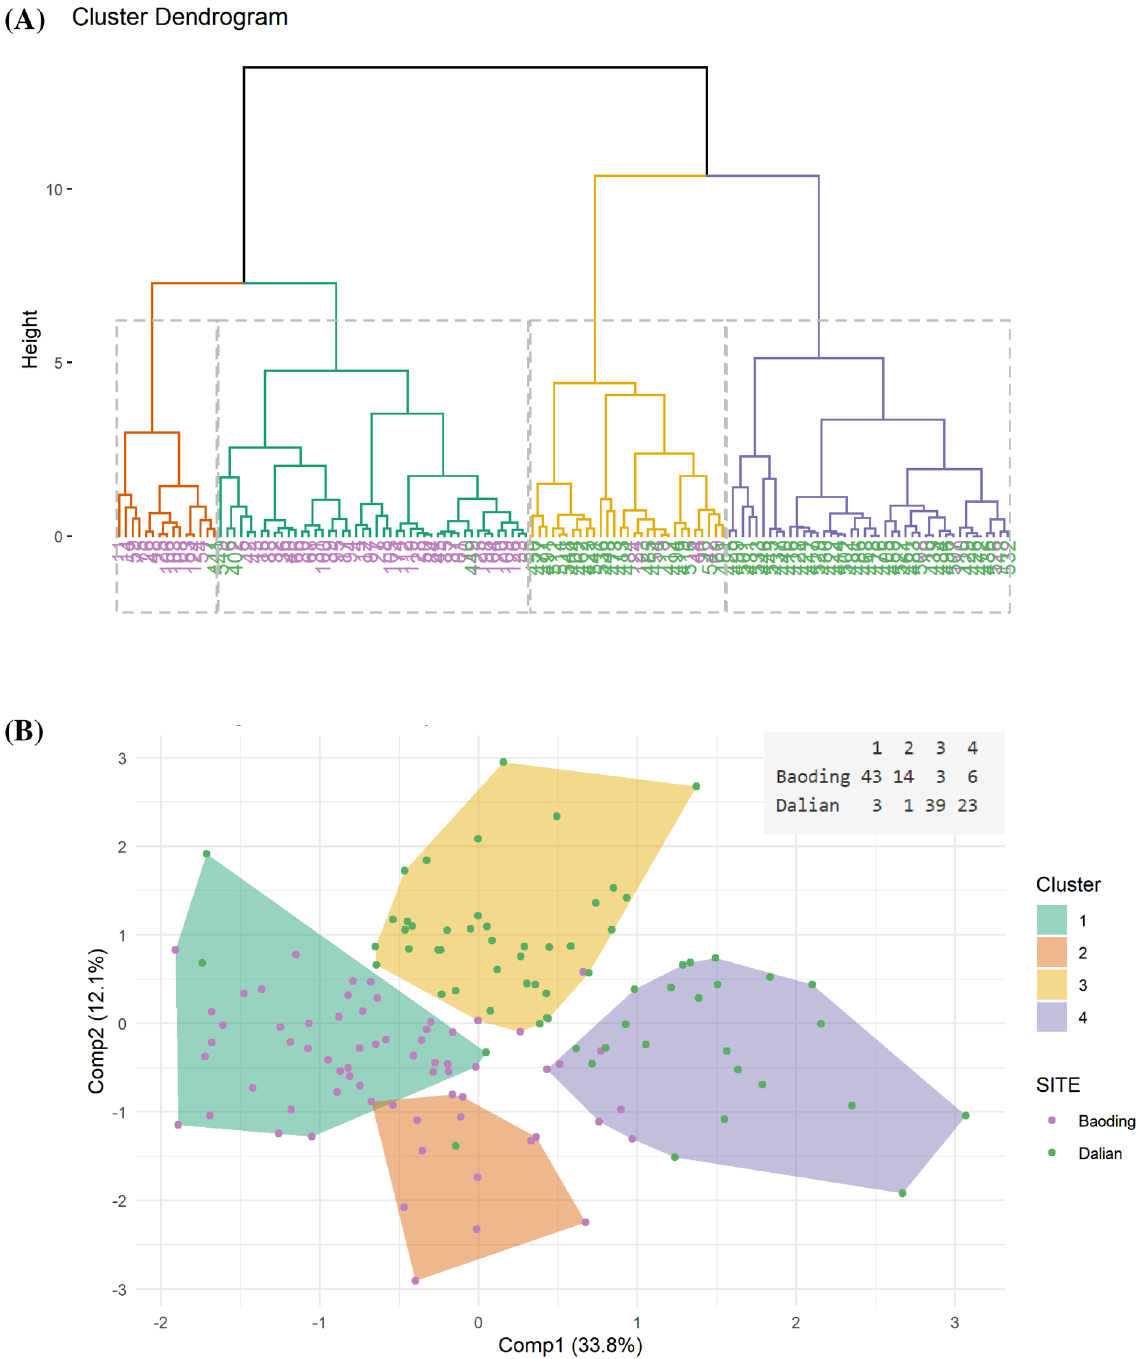
Figure 6. ( A ) Cluster dendrogram of the hierarchial clustering performed on the consensus space constructed by MAXVAR-A model from the PAH, metabolites and Bacteria OTUs selected by sCCA. Individuals are colored by cities. Based on the height of the gap between 2 consecutive level of the dendrogram, we chose to construct 4 clusters of individuals. ( B ) Representation of hierarchical clustering on the MAXVAR-A consensus space, with colored convex hull around cluster. The two first component of the consensus space represent 45.9% of the total variability. The table in the upper-right of the figure represents the repartition of individuals between the 2 cities, Baoding (More Polluted) and Dalian (Less Polluted), for each cluster. Figures were created using the R software: R Core Team (2017), R Foundation for Statistical Computing, Vienna, Austria. URL https:// www.R- proje ct.